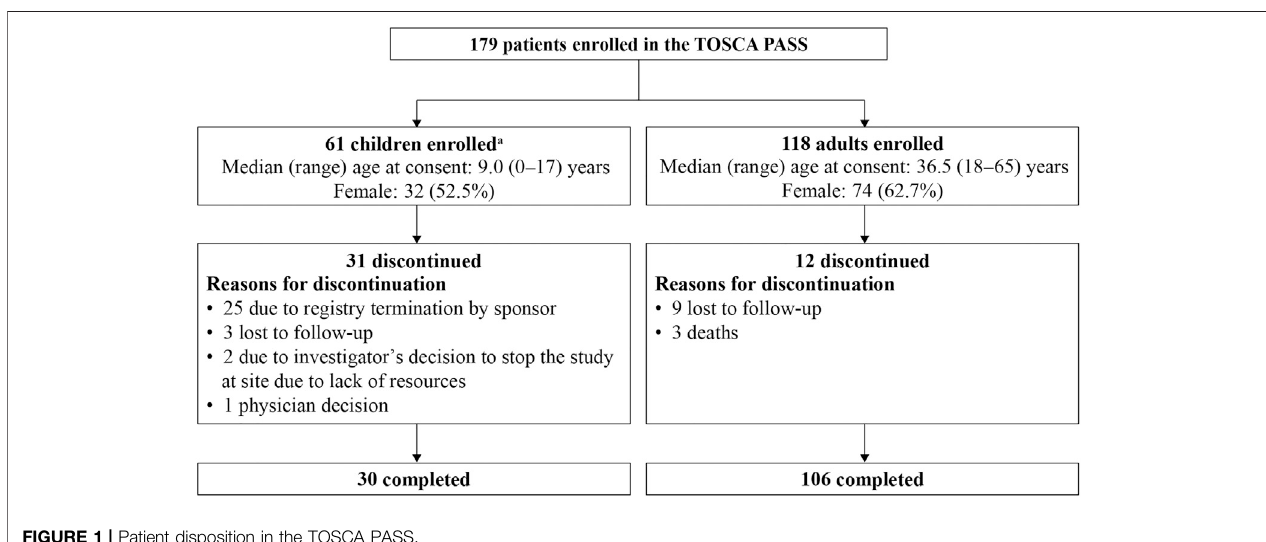
FIGURE 1 | Patient disposition in the TOSCA PASS. PASS, Post-Authorization Safety